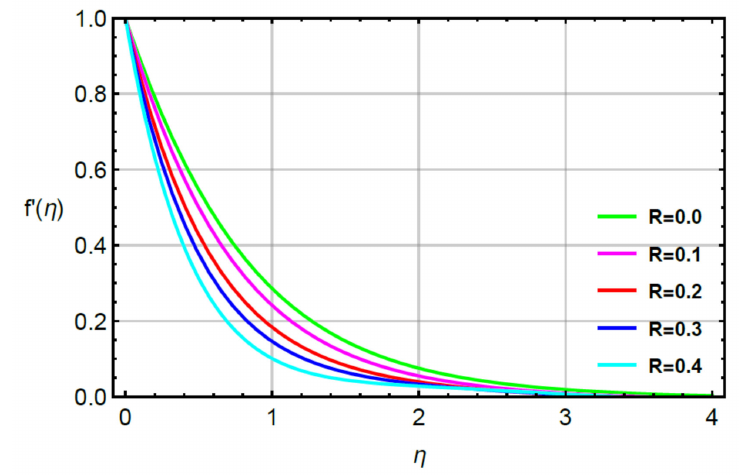
Figure 4. Behavior of f (cid:48) ( η ) for R when Sc = 0.6, Pr = 1.1, α 1 = 0.2 = α 2 , γ 1 = 0.3 = γ 2 , M = 0.1, δ = 0.8.